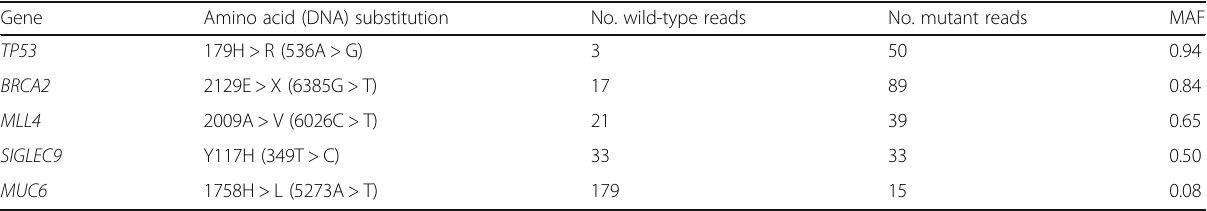
Table 1 Mutations detected by target-gene sequencing of the retroperitoneal high-grade serous carcinoma Gene Amino acid (DNA) substitution No. wild-type